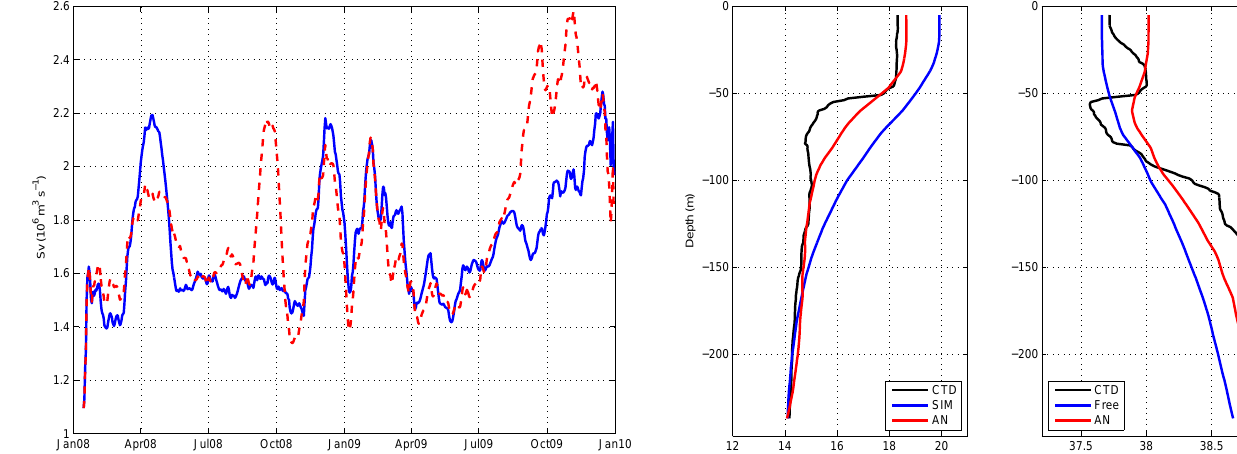
Fig. 10. Temperature (left) and salinity (right) profiles for AN Fig.10. Temperature(left)andsalinity(right)profilesforAN(green),SIM(red)andCTD(black)forasinglestation(11.60 ◦ E,36.34 ◦ N) duringNovember2009. (green), SIM (red) and CTD (black) for a single station (11.60 ◦ E, 36.34 ◦ N) during November